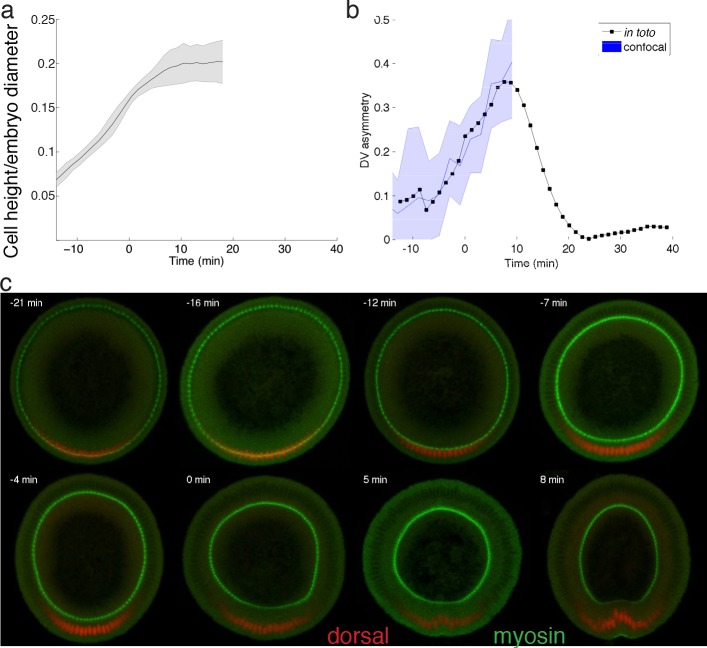
Basal myosin quantification light sheet versus confocal.(a) Cell height as a function of embryo diameter increases monotonically until ventral furrow formation starts. (b) DV asymmetry as a function of time, measured using light sheet (black), or confocal with time calibration curve according to cell height (blue). (c) Confocal recording of DV cross-sections of embryos cut along AP axis. Colors indicate localization of myosin and dorsal visualized via antibody staining. Embryos were fixed by heat-methanol fixation (Miller et al., 1989) for staining with mouse anti-Dorsal (1:50, 7A4-S Developmental Studies Hybridoma Bank (DSHB)) and rabbit anti-myosin II (Zipper heavy chain, 1:1000, [Sokac and Wieschaus, 2008]). Secondary antibodies coupled to Alexa Fluor 488 and Alexa Fluor 564 were used at a 1:500 dilution (Invitrogen).